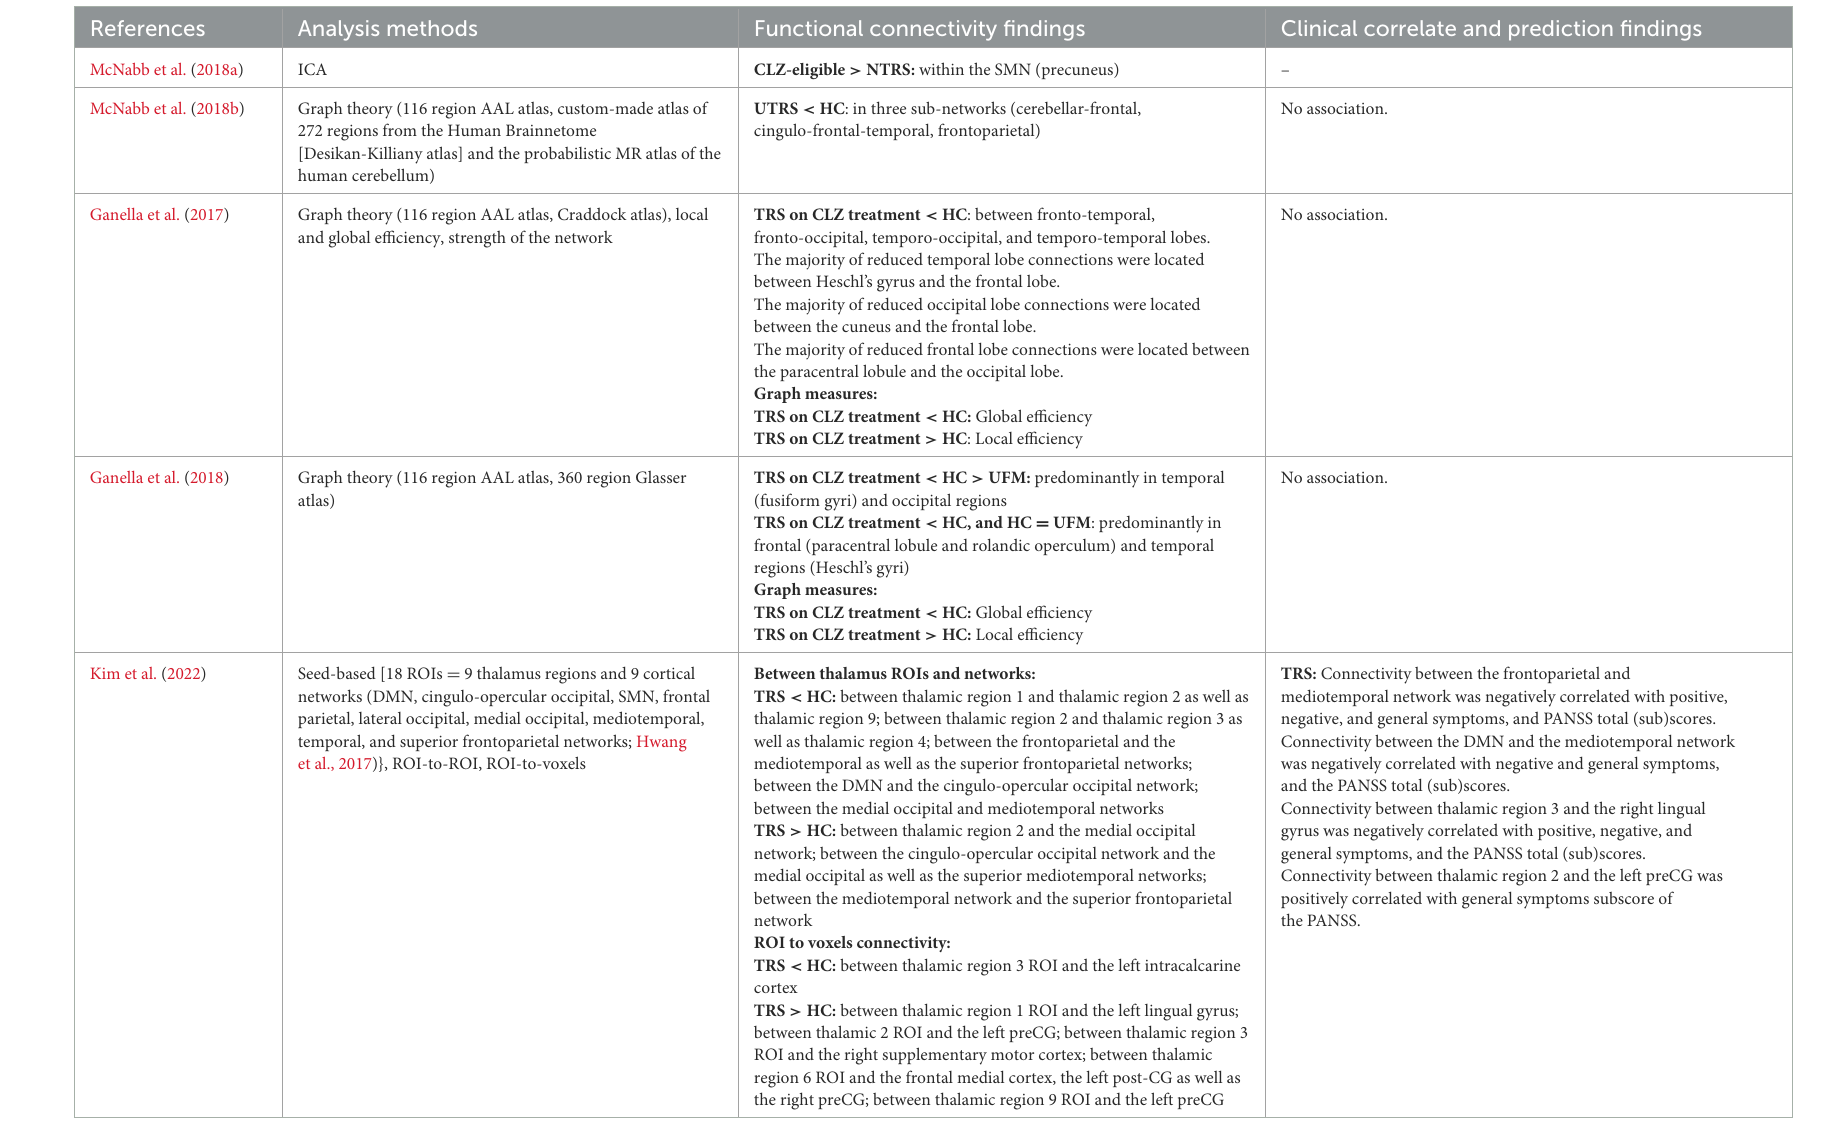
TABLE 2 Major findings of TRS studies with